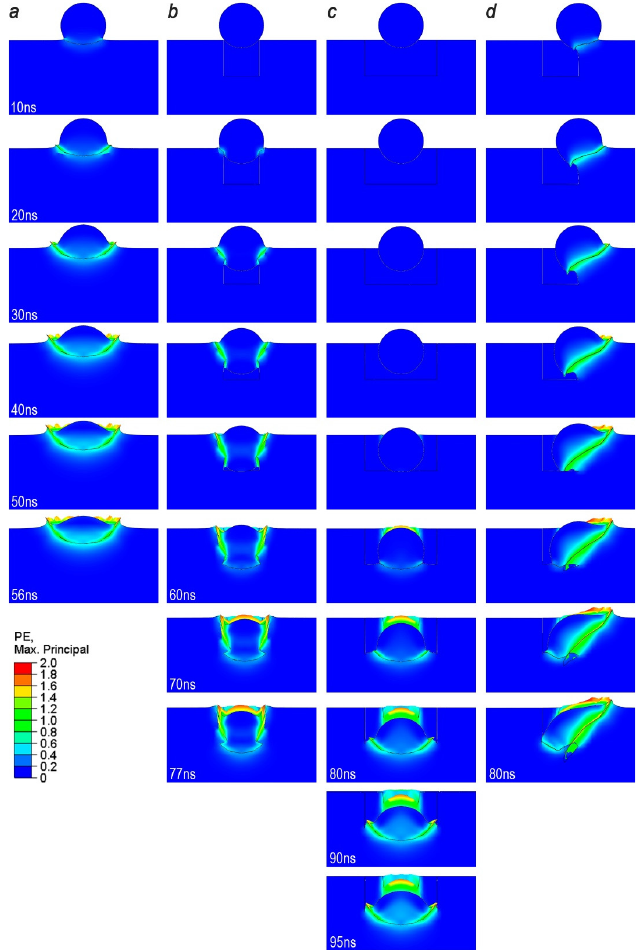
Figure 2. Plastic strain of the particle ( d P = 50 µ m) and the substrate at different times: ( a ) without microdefect; ( b ) with cube-shaped microdefect; ( c ) with rectangular-shaped microdefect; ( d ) with the particle collision on the edge of cube-shaped microdefect.